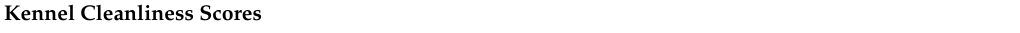
Table A1. Cleanliness scoring tool. The tool used to score body and kennel